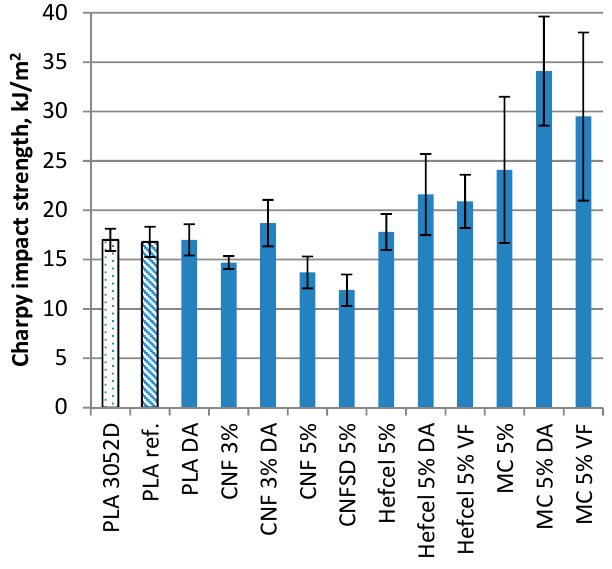
Figure 7. Charpy impact strength (unnotched) results for injection molded PLA composites with cellulosic fiber content of 3% or 5%.